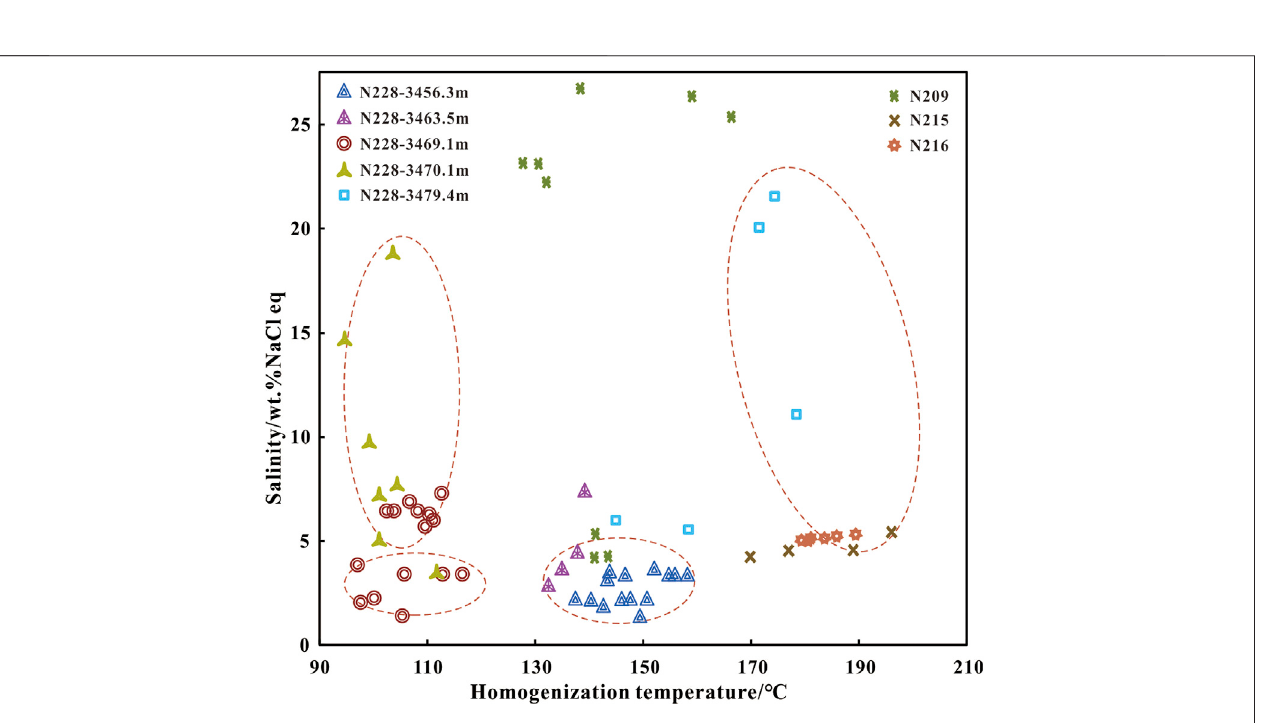
Frontiers in Earth Science |